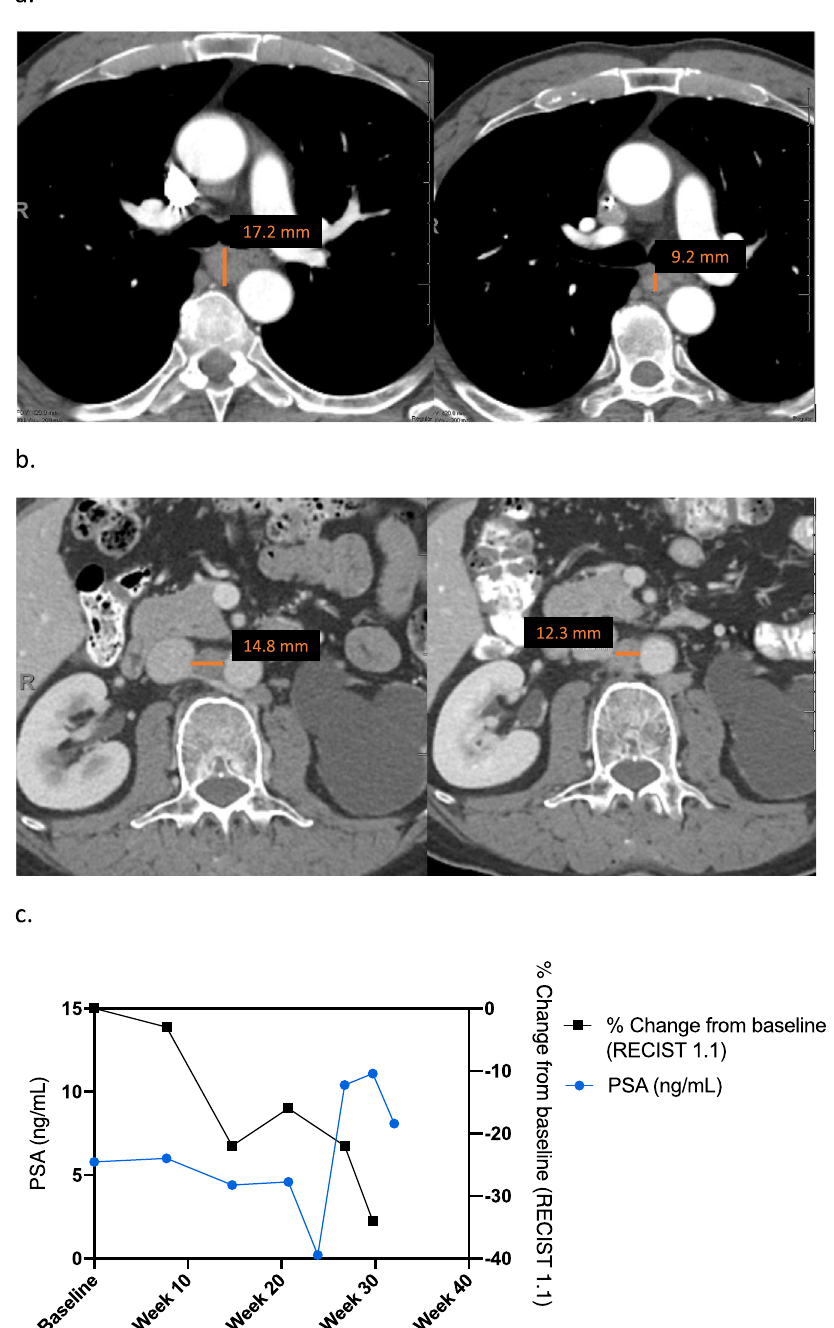
Fig. 3 Representative sections of computerized tomography and PSA trend in patient #17 with metastatic castrate resistant prostate cancer harboring PTEN deletion. Panels ( a ), ( b ) show response in mediastinal ( a ) and retroperitoneal ( b ) nodal metastases. c XY plot of the PSA (ng/mL) levels (blue, left Y axis) and % change from baseline (RECIST v1.1) in relation to time. Plot was created using GraphPad Prism version 9.2.0 for Mac OS, GraphPad Software, San Diego, California, USA, 15 of each cycle. After the 6 cycles were completed, patients were sapanisertib in combination with carboplatin plus paclitaxel in treated to progression with sapanisertib 3 mg PO daily. The patients with advanced solid malignancies. Patients were treated rationale behind limiting chemotherapy to six cycles was to avoid with as many as six, 21-day cycles of the combination regimen overlapping cumulative toxicity. Sapanisertib was continued as a (Fig. 5). The regimen was comprised of carboplatin (targeting area maintenance therapy given the well-known resistance emerging under the curve -AUC- 5 mg/mL (cid:129) min) intravenously every 3 weeks from chemotherapy. This protocol utilized a standard 3 + 3 on Day 1 of each cycle plus sapanisertib (TAK-228 or MLN0128) design. Three patients were treated per dose level. DLT was daily on Day 2 – 4 of each week at 2 mg, 3 mg and 4 mg orally and de fi ned if the events occur between Day 1 and Day 21 of the fi rst paclitaxel 40 mg/m2, 60 mg/m2, 80 mg/m2 QW IV on Day 1, 8, and